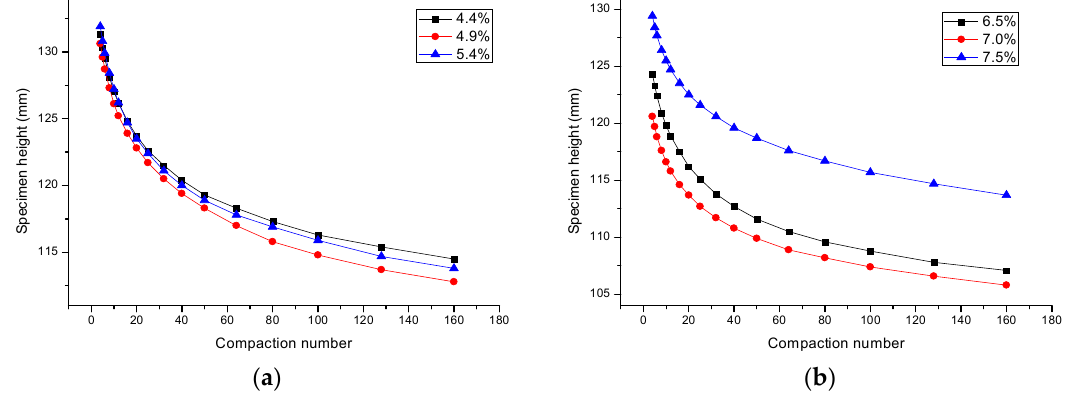
Figure 7. Relationship between compaction number and specimen height for ( a ) Aggregate A under a moisture content of 4.4%, 4.9% and 5.4% and ( b ) Aggregate B under a moisture content of 6.5%, 7.0% and 7.5%. Table 3. Fitting results of compaction curves.